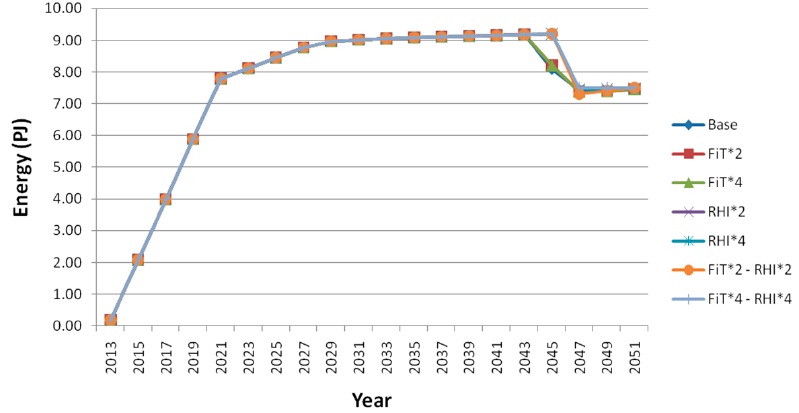
Figure 19. Specialist poultry farms—grid electricity consumption.